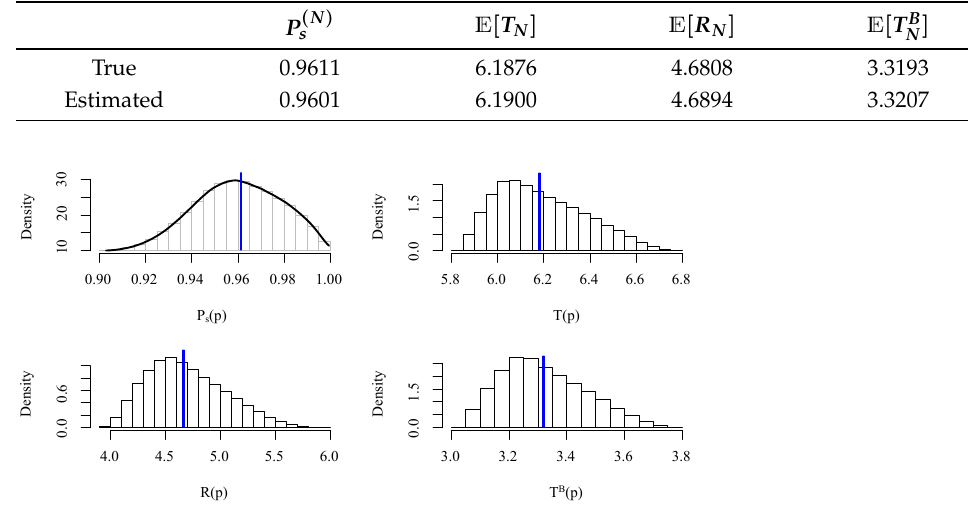
when considering random N